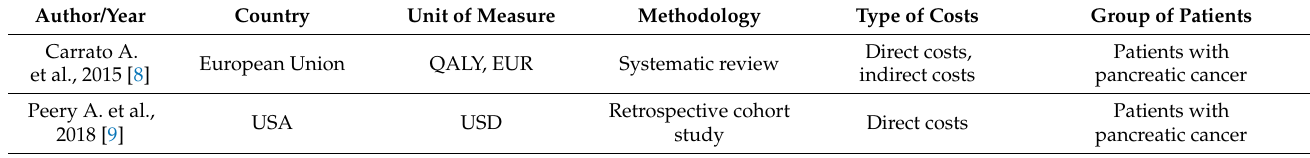
Table 2. Characteristics of publications included in the